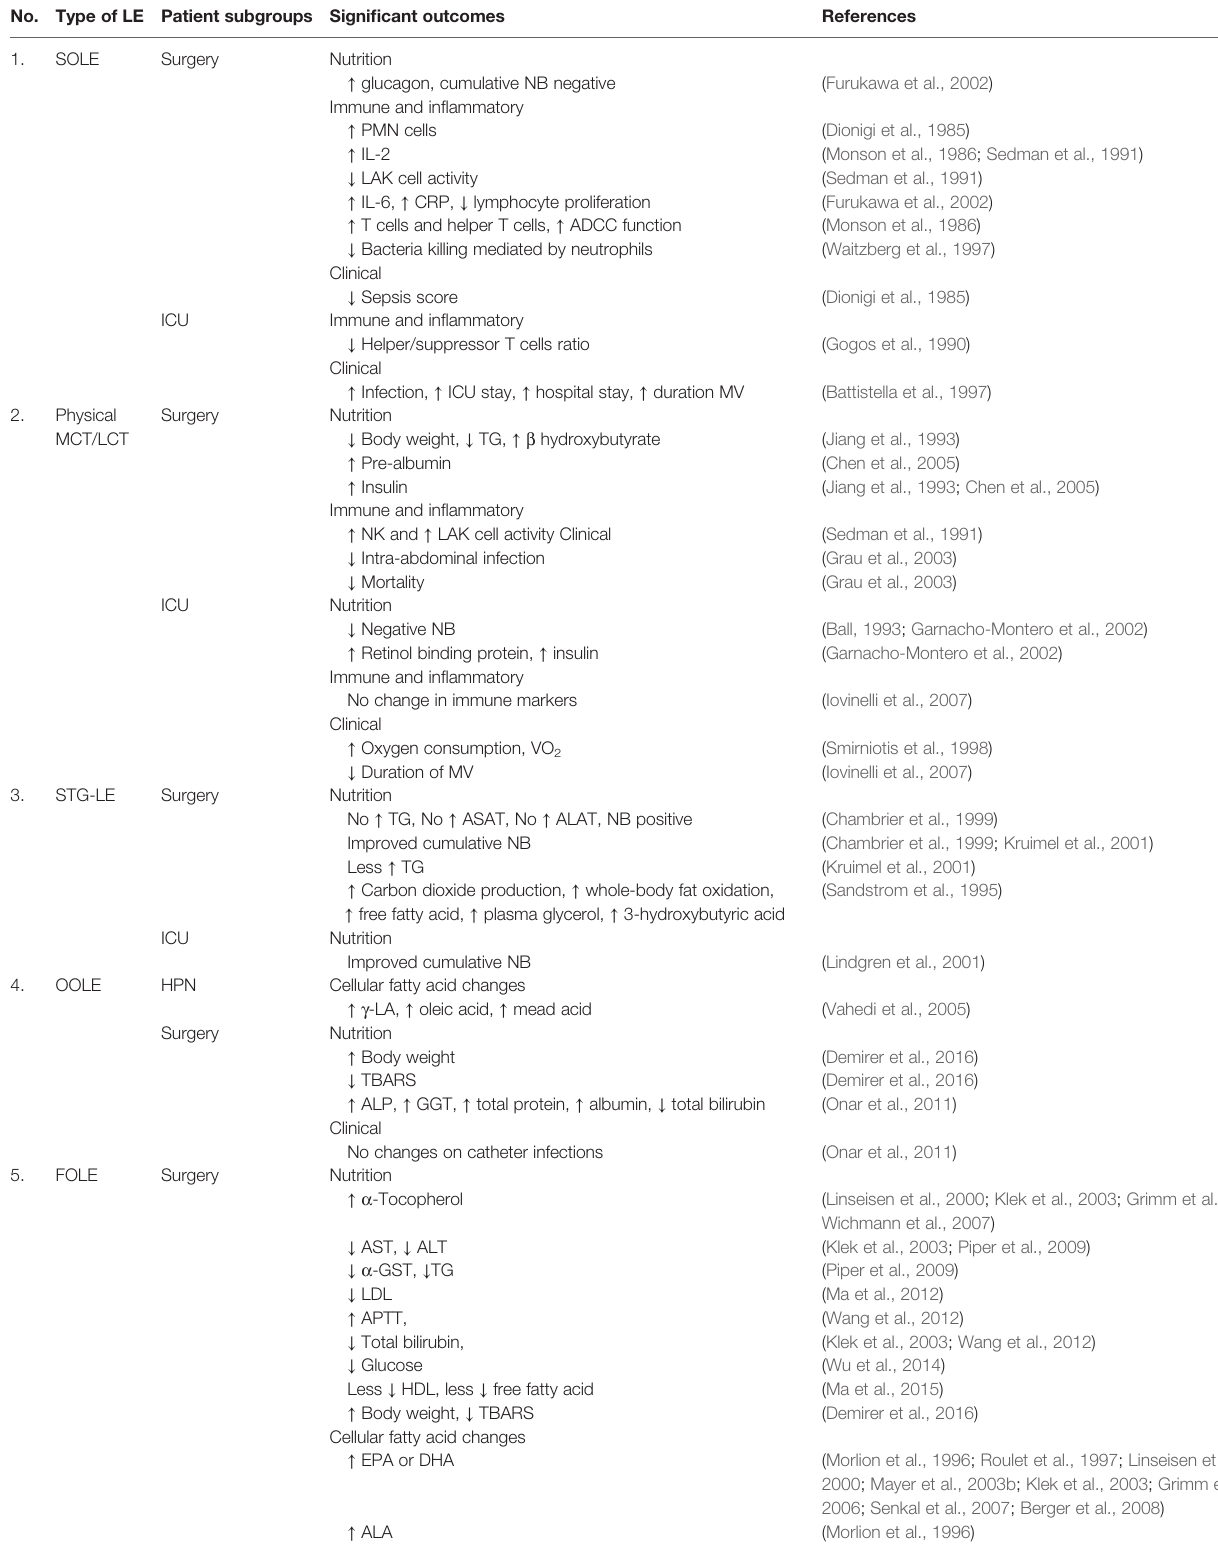
TABLE 4 | Clinical outcomes of randomized controlled trials categorized as per lipid emulsion formulation type. No. Type of LE Patient subgroups Signi fi cant